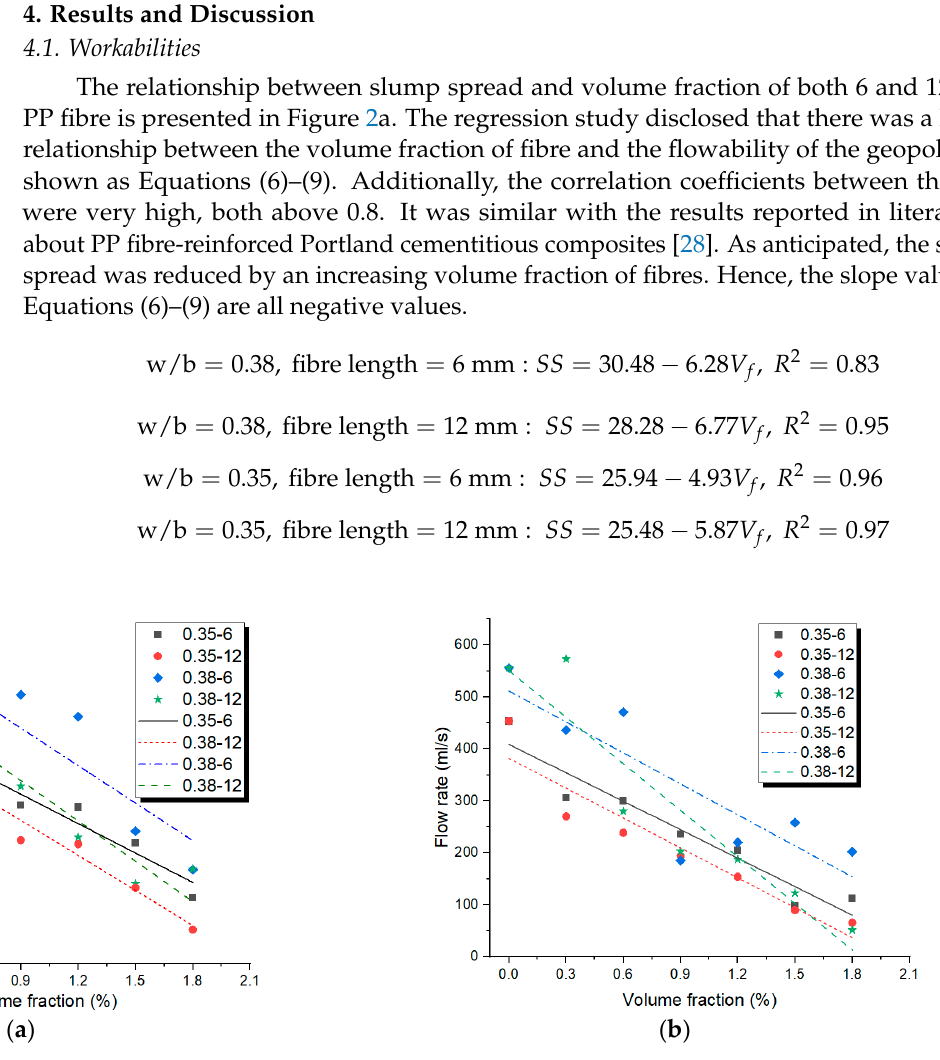
Figure 2. Relationships of ( a ) fibre volume fraction-slump spread; ( b ) fibre volume fraction-flow rate of PP fibre-reinforced geopolymer.